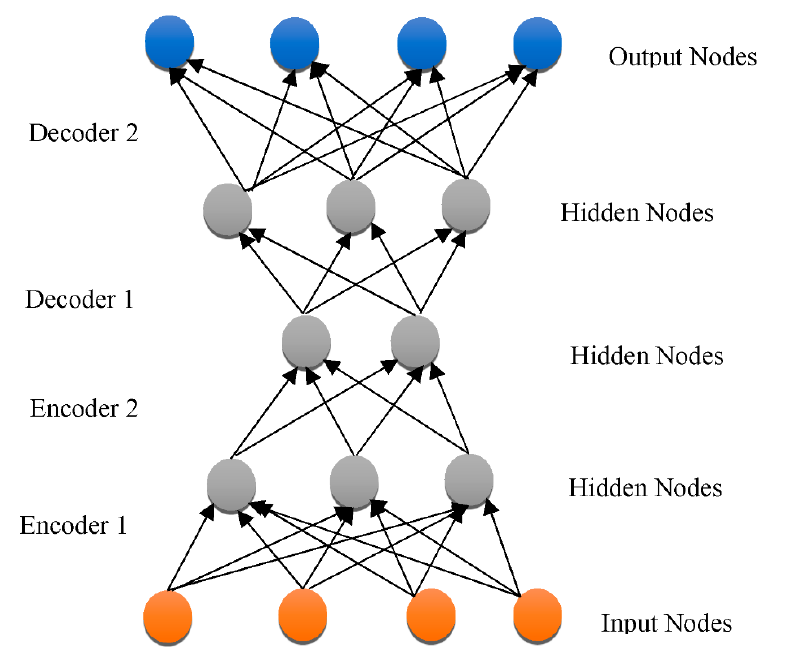
Figure 9. Sparse AE architecture.